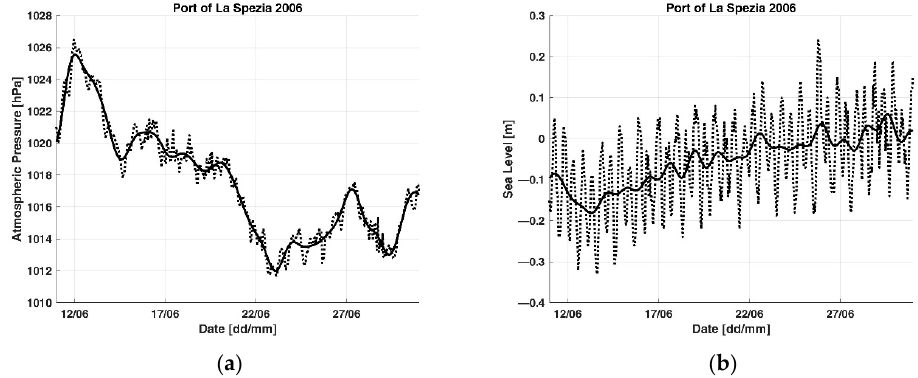
Figures A1–A4 (in this Appendix A) and S1–S45 (in the Supplementary Material) show data acquired during the events listed in Table A1; solid lines represent low-fre- quency components survived the Low-Pass filtering; dashed lines represent high-fre- quency components removed by the Low-Pass filtering.